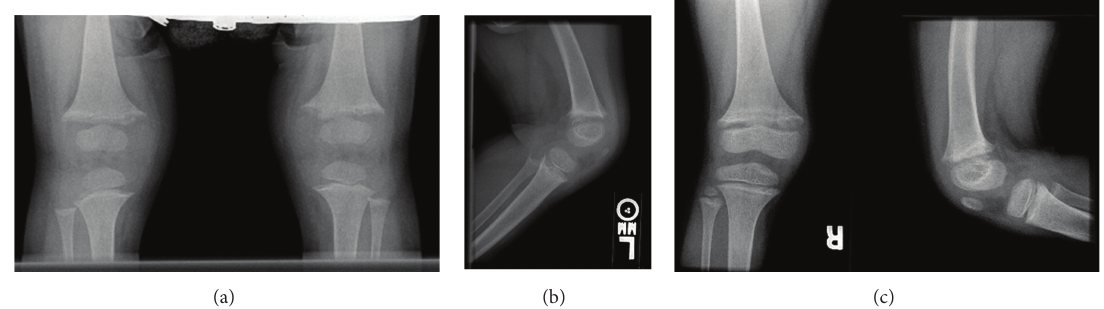
Figure 1: Radiographs of knees at diagnosis (a) and before phosphate and calcitriol were commenced. (a) Radiograph of both knees at 1 year of age showed irregularity, fraying and flaring of the distal femoral and proximal tibia metaphyses bilaterally. (b) Radiograph of knees at 3 years of age showed worsening rickets with increased widening, cupping and fraying of metaphyses of the distal femur, the proximal tibia, and fibula. (c) Radiograph of knees at 4 years of age showed persistent widening of metaphyses in both knees.